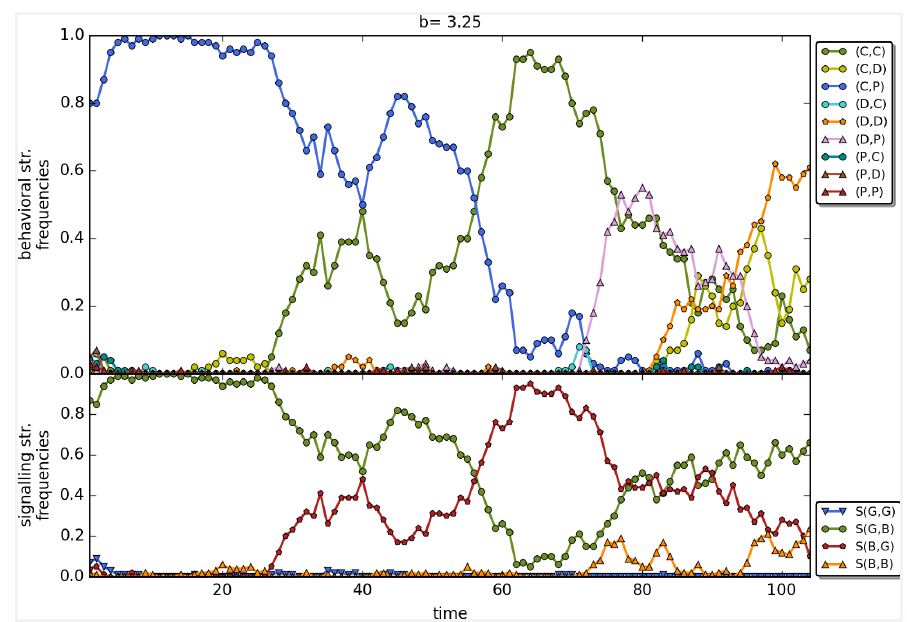
Fig 11. The timeline of an individual run using the social norm shunning. The figure shows the change in the frequencies of the behavioural and signalling strategies as a function of time for the social norms shunning. Numbers on the x axis denote 100 steps. Parameters: n = 100, b = 3.25, c = 1, α = 1, β = 4, MST = 80%. Colour code for behavioural strategies: